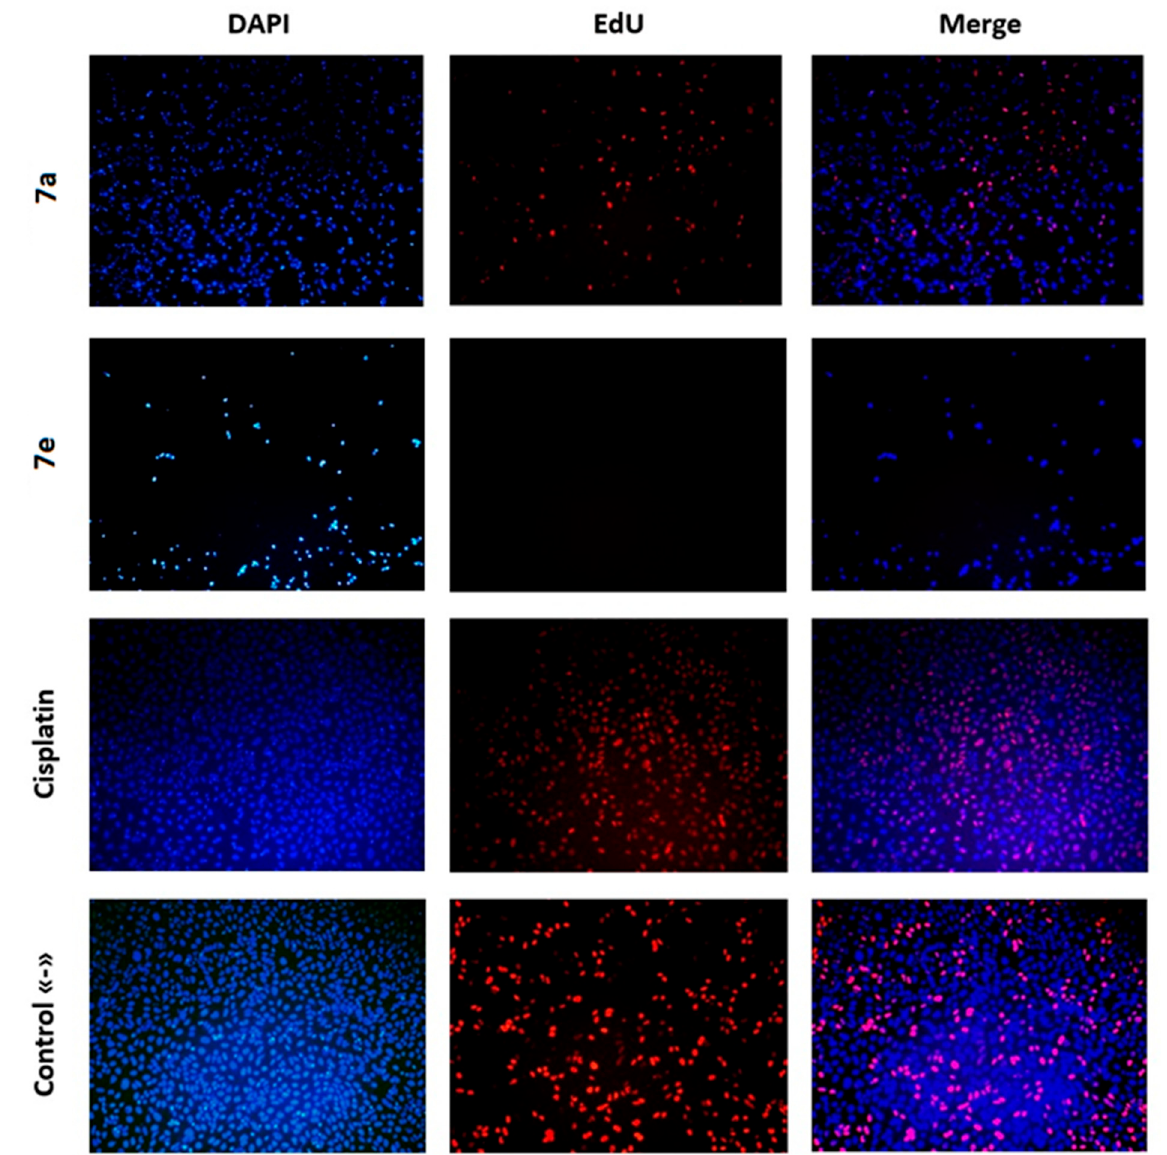
Figure 7. Assessment of DNA synthesis intensity in human glioblastoma cell cultures of the A-172 line under the influence of compounds 7a and 7e . Blue color stains the nuclei of all cells using DAPI dye, and red nuclei of cells with active DNA synthesis (EdU), at 100× magnification.